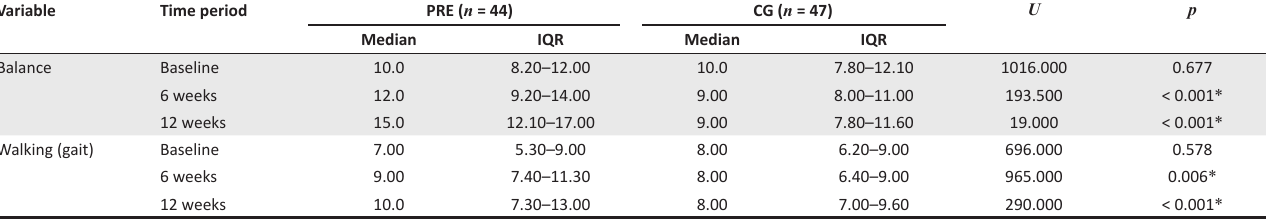
TABLE 3: Between-groups comparison of the outcomes at baseline, 6 weeks and 12 weeks.